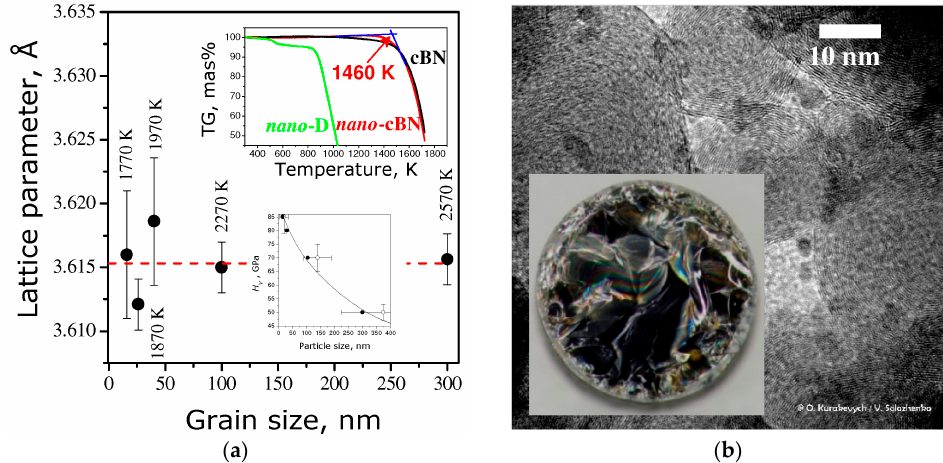
Figure 4. ( a ) Lattice parameters of nano-cBN as a function of grain size; oxidation stability (top inset) and hardness vs. grain size (bottom inset); ( b ) TEM image of nano-cBN grains and the view of the bulk sample recovered from HPHT (inset).